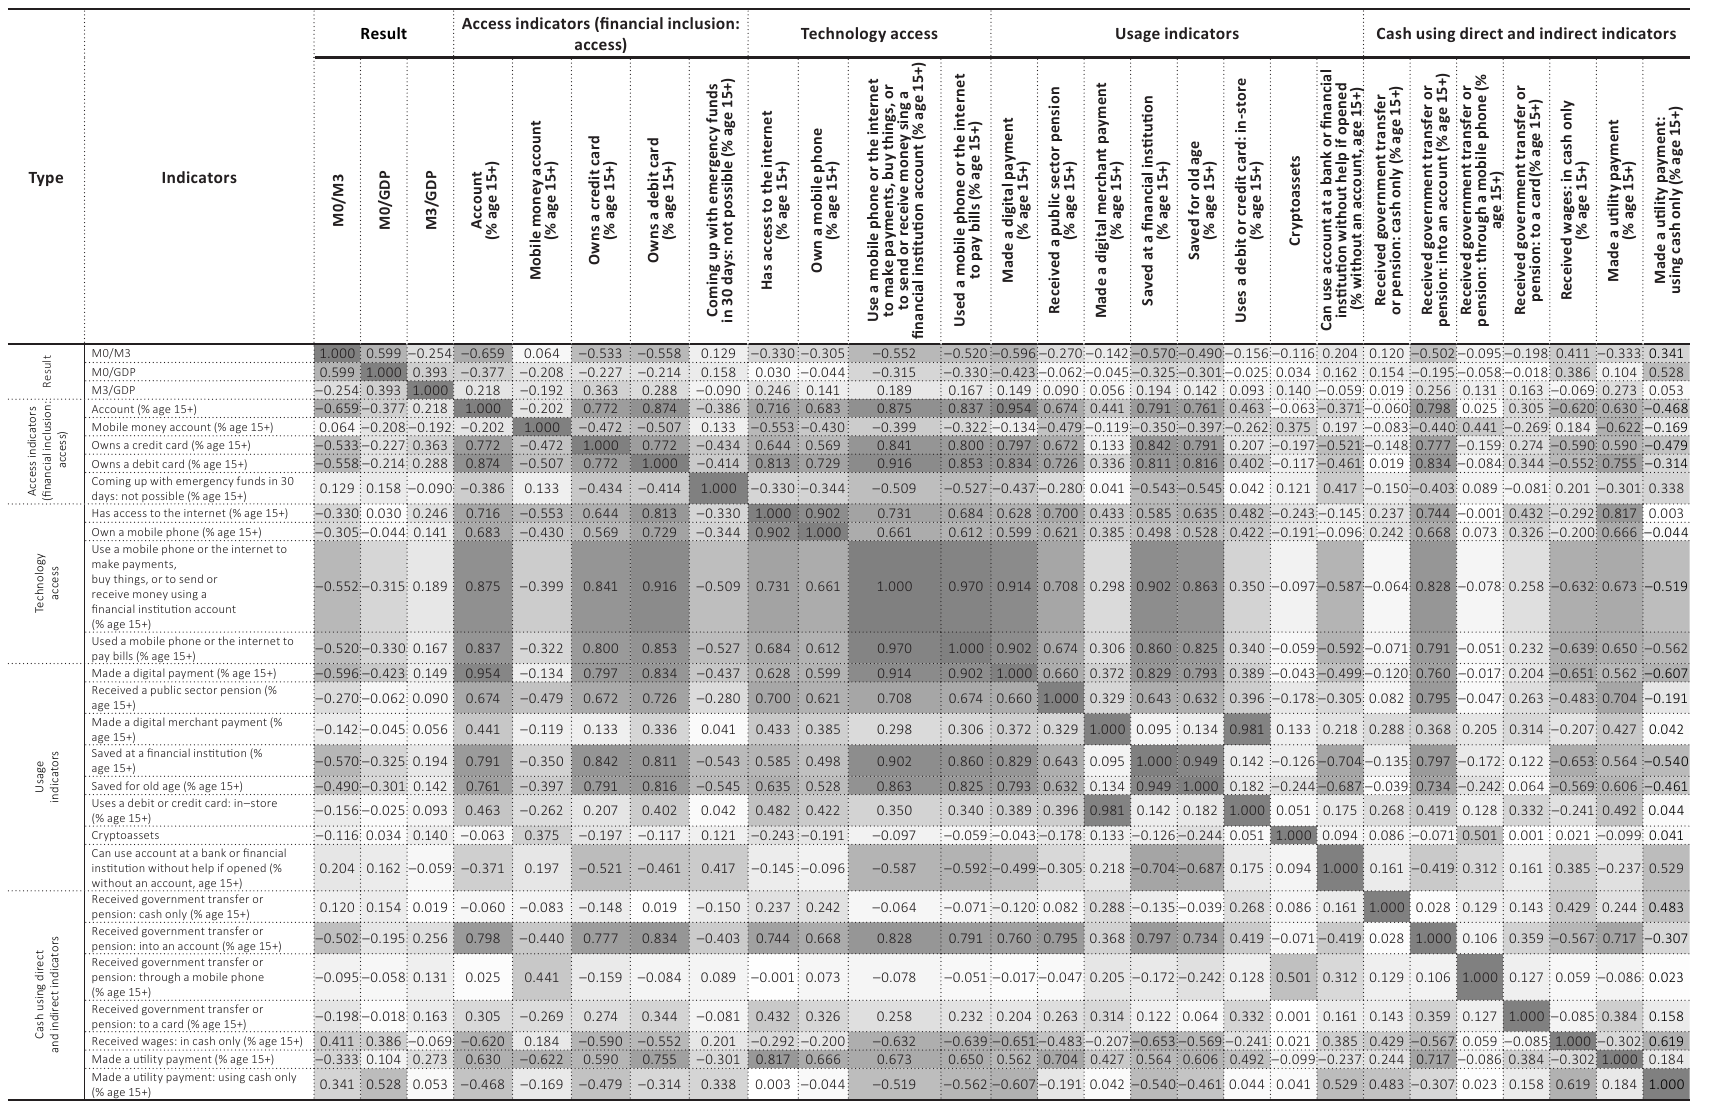
Table 1. Correlation matrix between